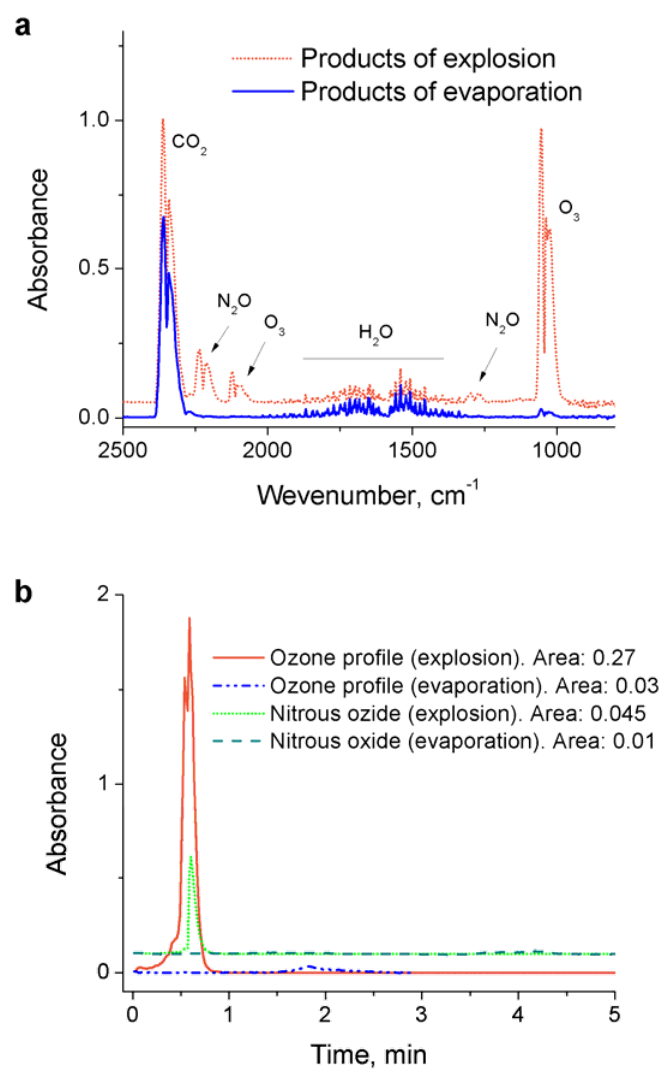
Figure 3. ( a ) FTIR spectra of gaseous products of the plasma-produced material (treated with activated carbon) evaporation and explosion in air; ( b ) time evolution of the ozone (1050 cm − 1 ) and nitrous oxide (2235 cm − 1 ) peaks.